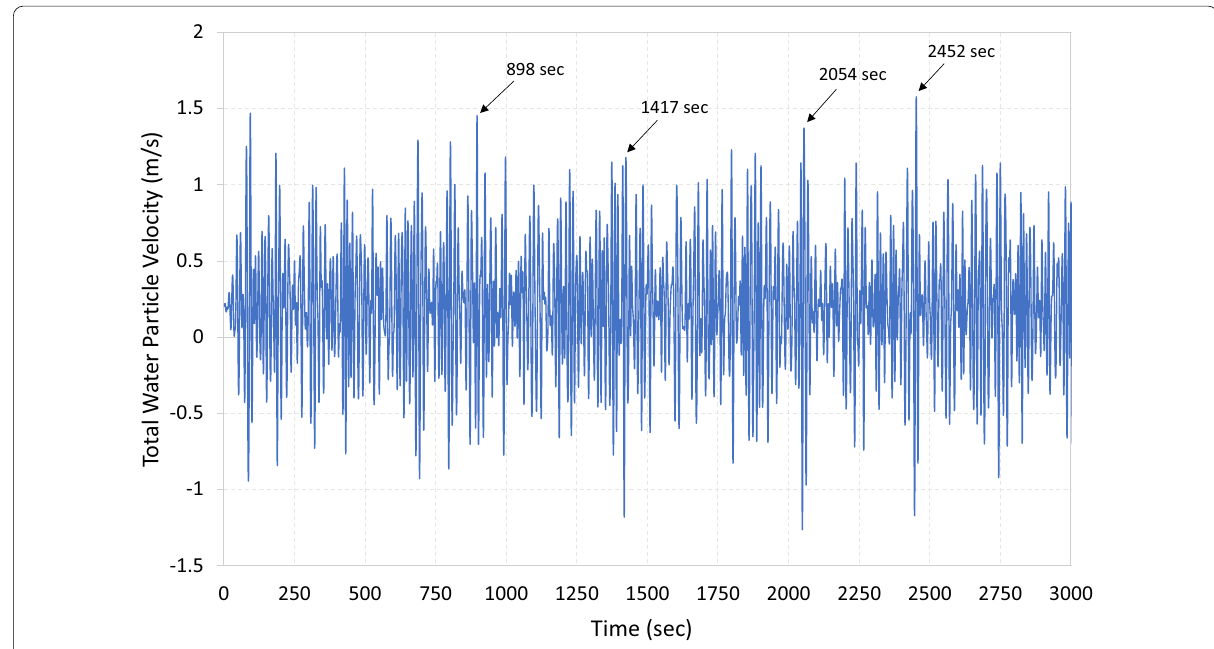
Fig. 13 Time history of the lateral velocity of the water particle at the pipeline right end for 180 mm concrete coating thickness